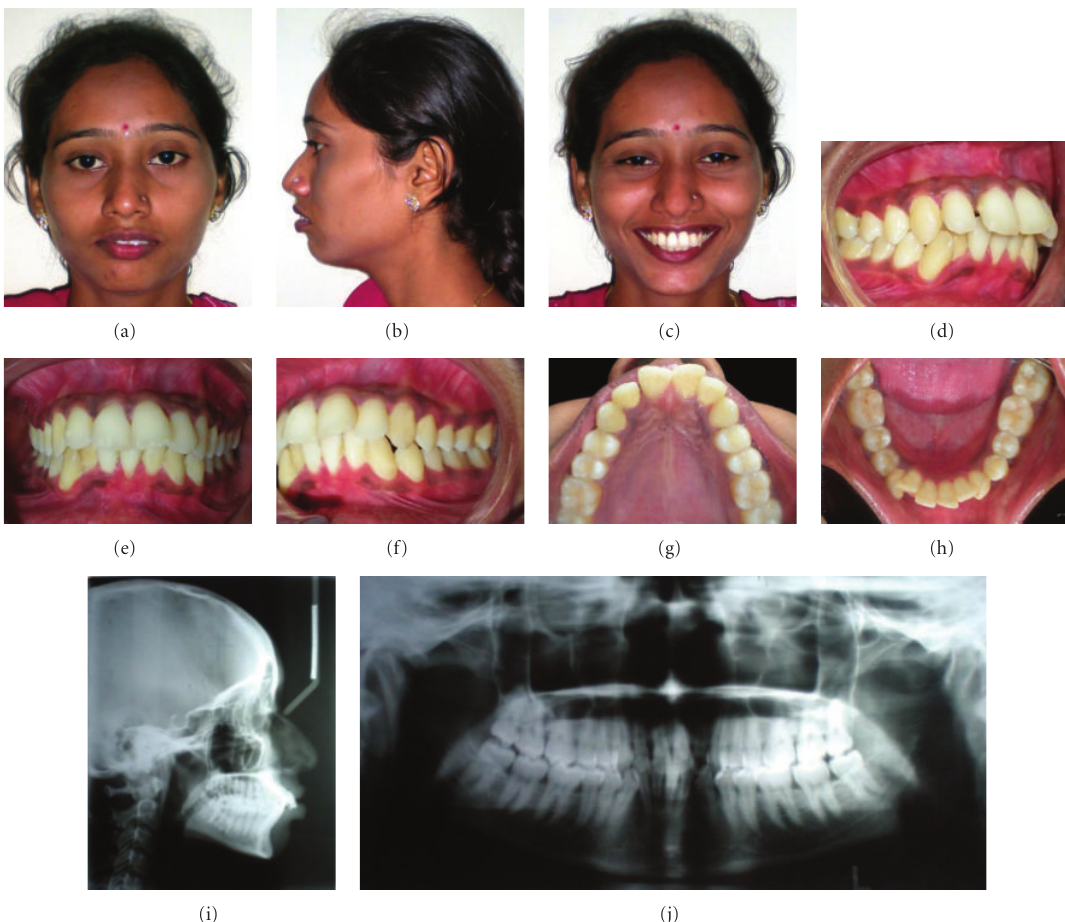
Figure 6: (a–j) Pretreatment photographs and